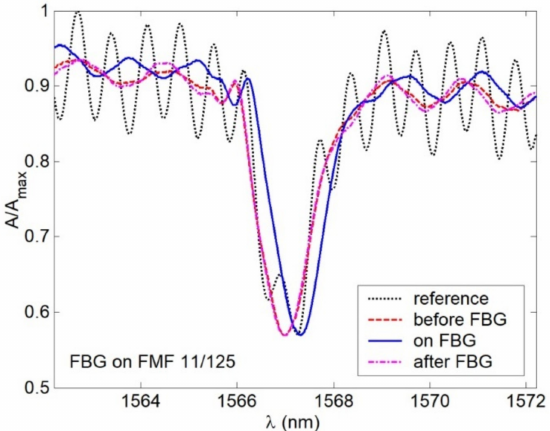
Figure 14. Spectral responses under 15 mm loop before, after and on the FBG, written on FMF 11/125.